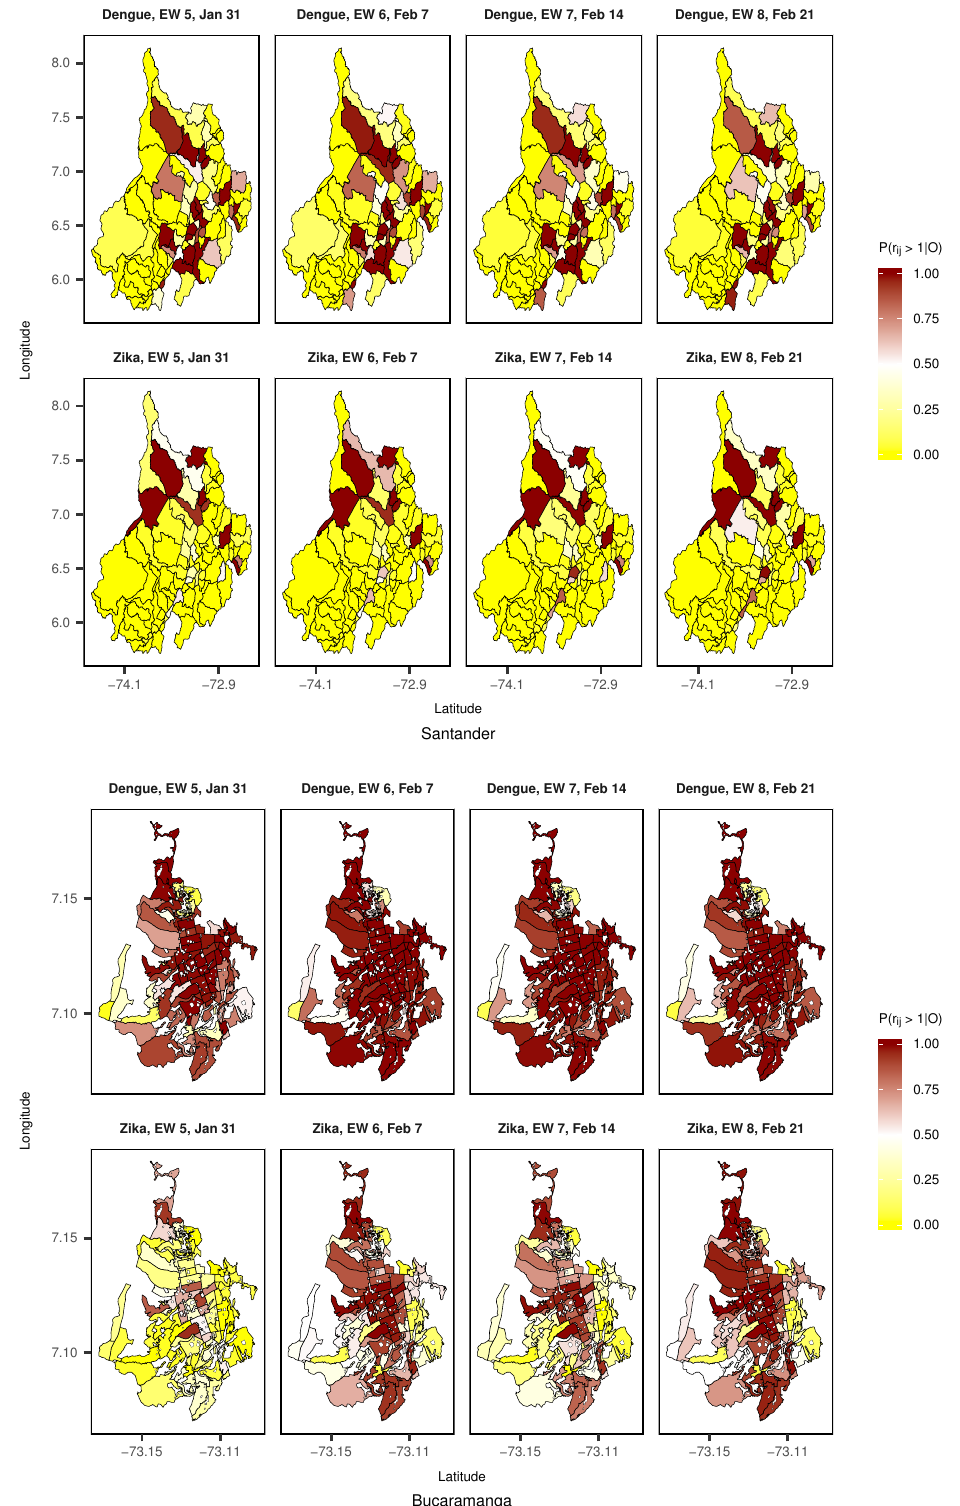
Figure 8. Evolution of the probability of dengue and Zika virus disease (ZVD) relative risk greater than 1 given the observed cases (P( r ij > 1 | O )) for selected epidemiological weeks (EWs) in January and February 2016 in the department of Santander and the city of